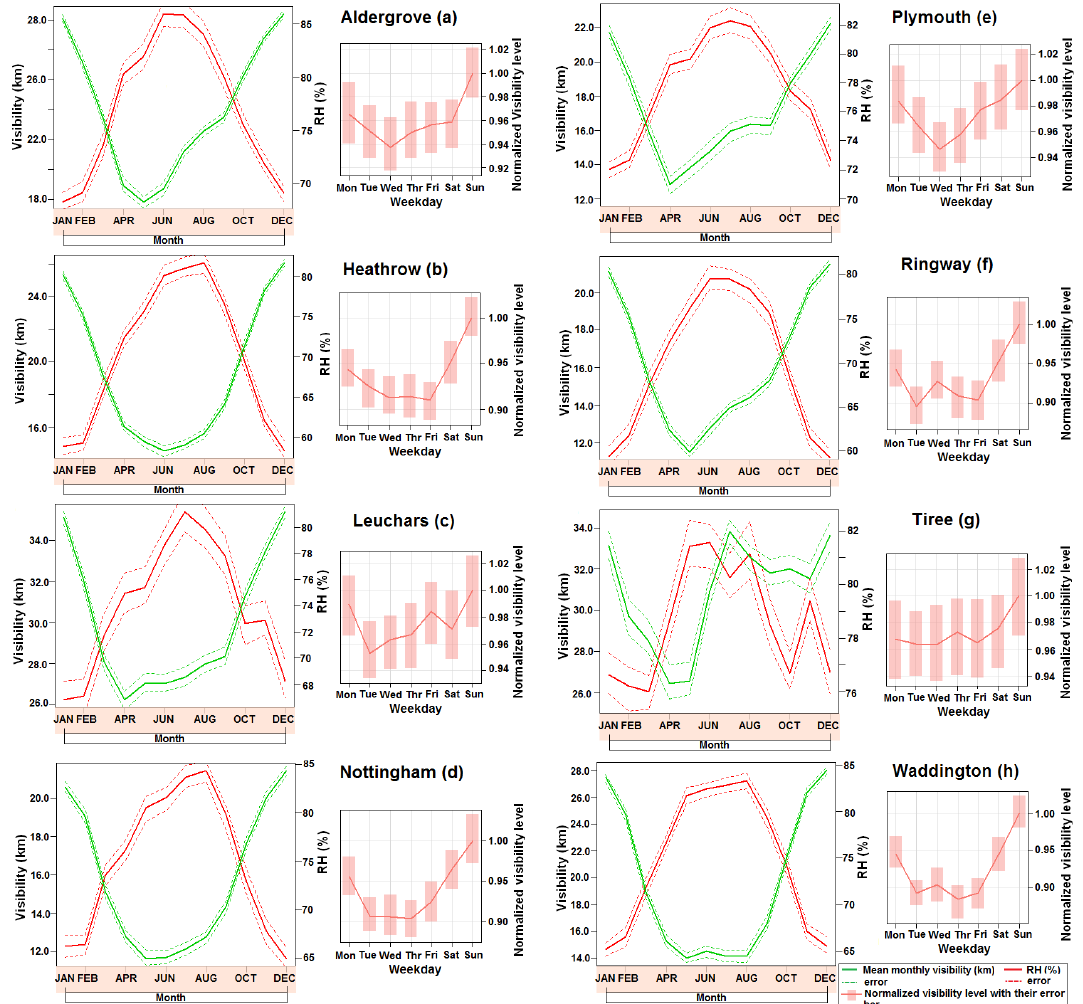
Figure 3. Mean monthly visibility and RH (left side) and average weekday visibility normalized to Sunday mean values (right side) at all eight sites: (a) Aldergrove, (b) Heathrow, (c) Leuchars, (d) Nottingham, (e) Plymouth, (f) Ringway, (g) Tiree, (h)